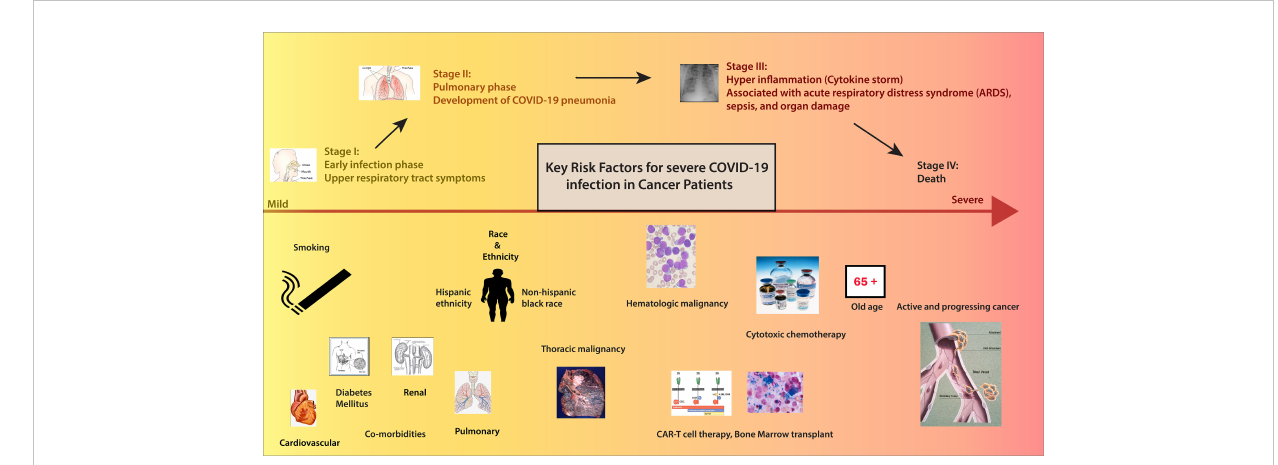
FIGURE 3 Risk factors of patients with Cancer in COVID-19. Credits for Active cancer image: Jane Hurd. National Cancer Institute.